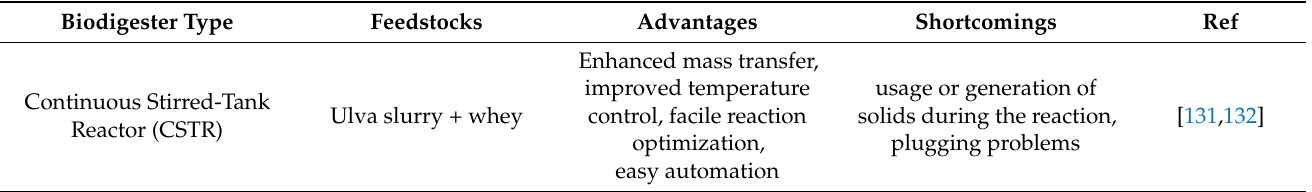
Table 2. Advantages and disadvantages of various digester types used in AD process when one or more feedstocks are